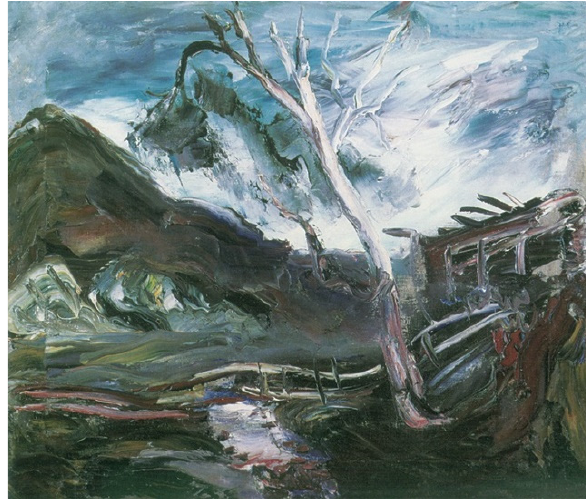
Figure 7. A. Drevin. The Dry Birch . 1930.